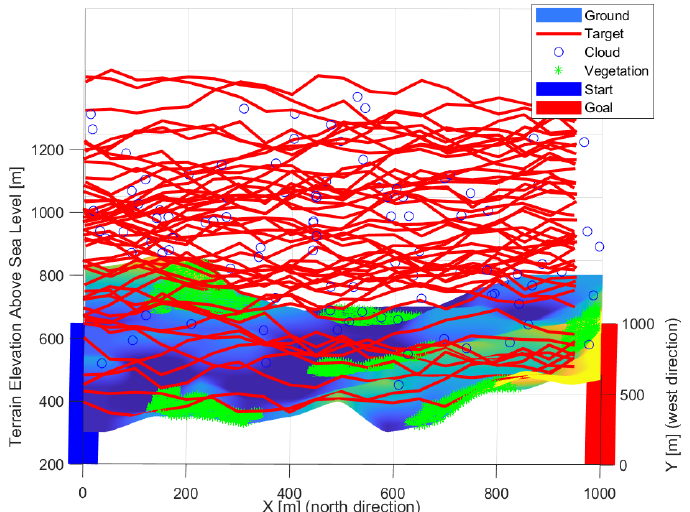
Figure 4. The different paths (red lines) of the objects quasi evenly filled the study area.